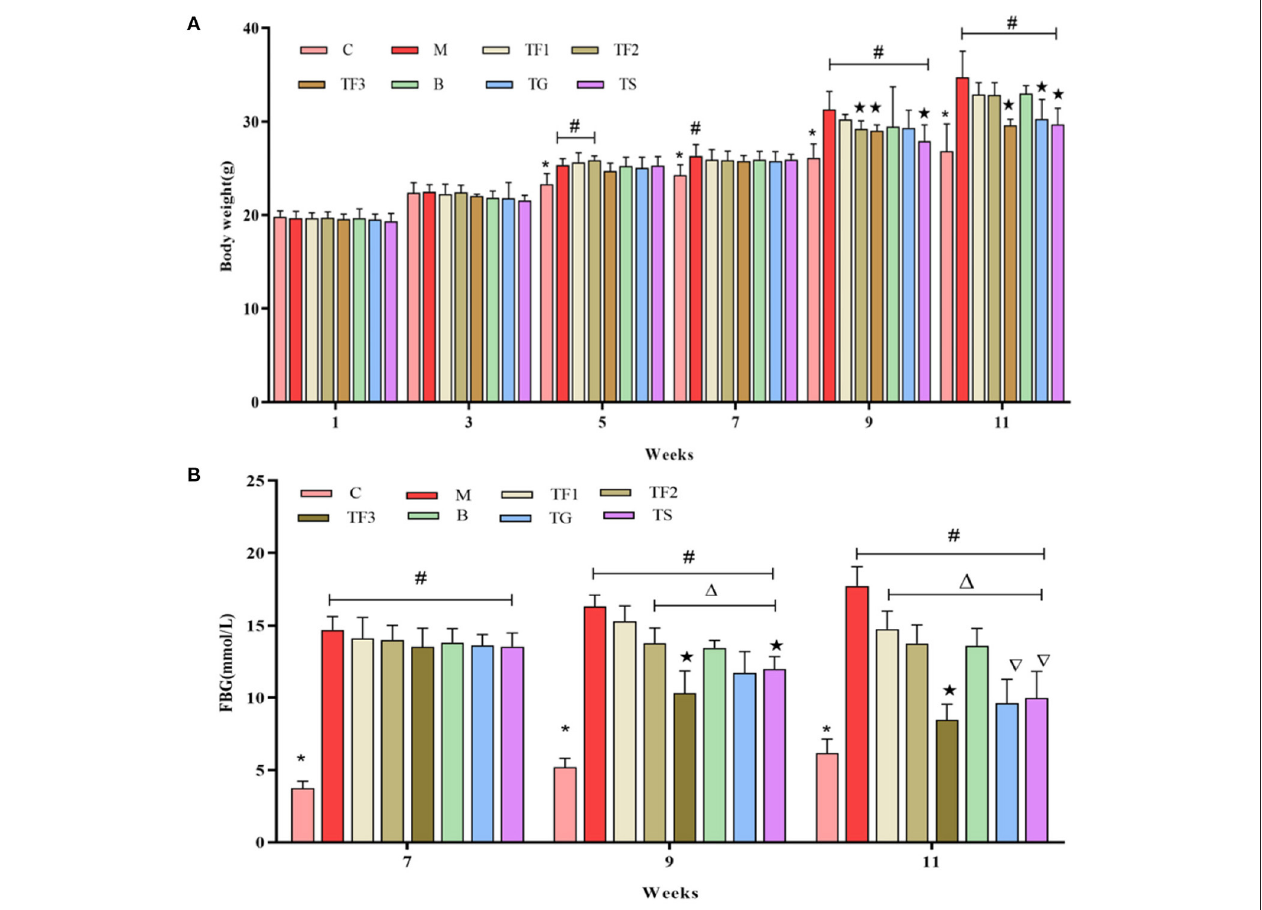
FIGURE 1 | Effect of GABA-rich sprouted adzuki beans on the body weight (BW) and FBG level of mice with T2DM. The values represent the mean ± SEM ( n ≥ 5); (A) BW of mice at different time points; (B) FBG levels of mice during dietary intervention; values with different symbols differ substantially ( p < 0.05) from each